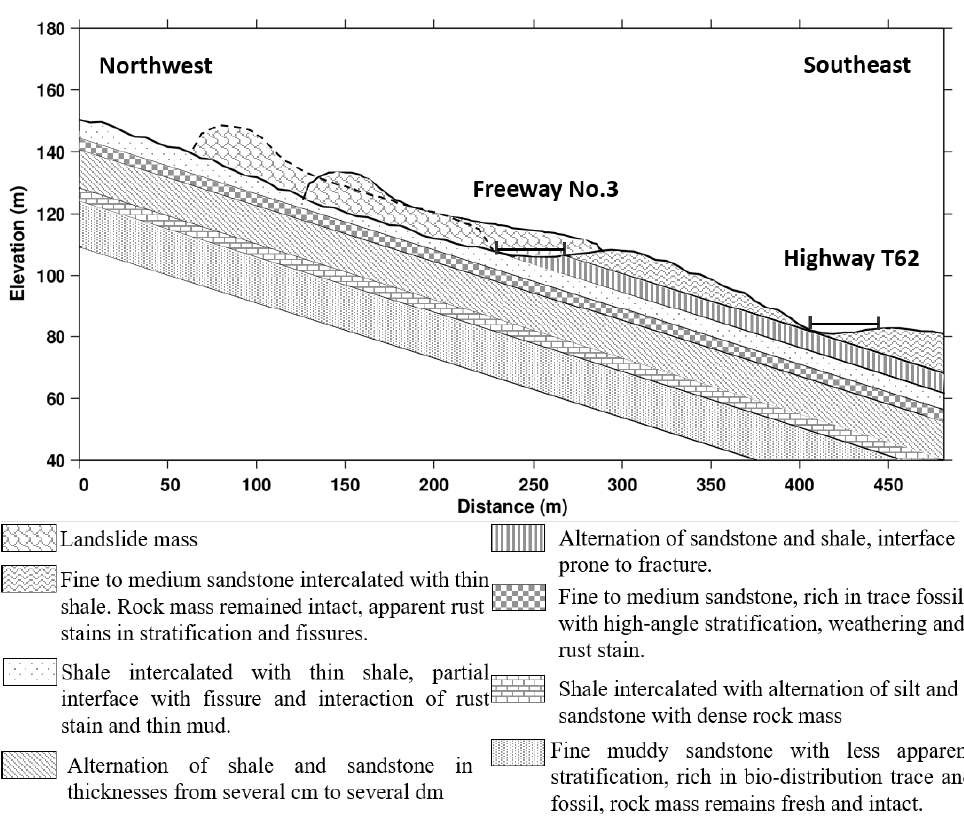
Figure 2. Engineering geological profile of the artificial side slope after failure. The location of profile is indicated in Figure 7 (Modified from Figure 3 in [4]).